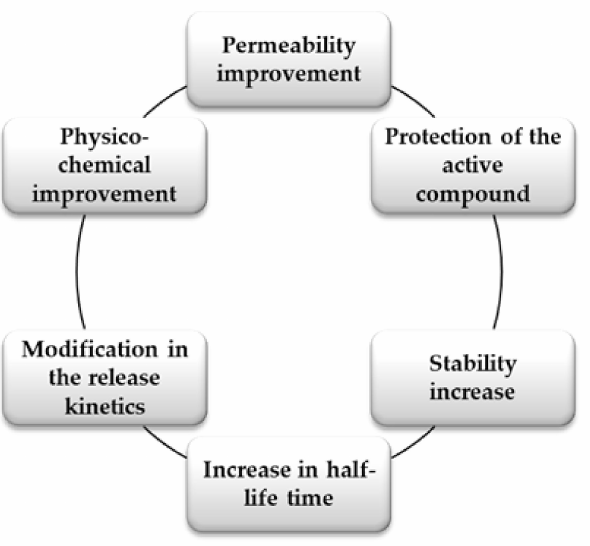
Figure 6. The advantages of multilayer encapsulation of active